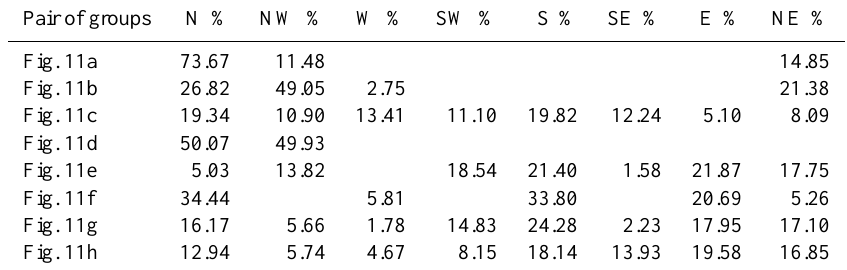
Fig.11 Examples of pairs of object groups used in the experiment: (a) point  Fig. 11. Examples of pairs of object groups used in the experiment: ( A ) point → point group; (b) line → point group; (c) polygon → point group; (d) line → line network; (e) line → linear arranged polygon group; (f) polygon group → line network; (g) polygon cluster → linear point group; (b) line  point group; (c) polygon  point group; (d) line  line arranged polygon group; (h) polygon → complex group with polygons, lines and points. network; (e) line  linear arranged polygon group; (f) polygon group  line network; (g) polygon cluster  linear arranged polygon group; (h) polygon  Table 4. Qualitative direction relations of the pairs of object groups (the percentages are the weights of the directions). complex group with polygons, lines and points. Pair of